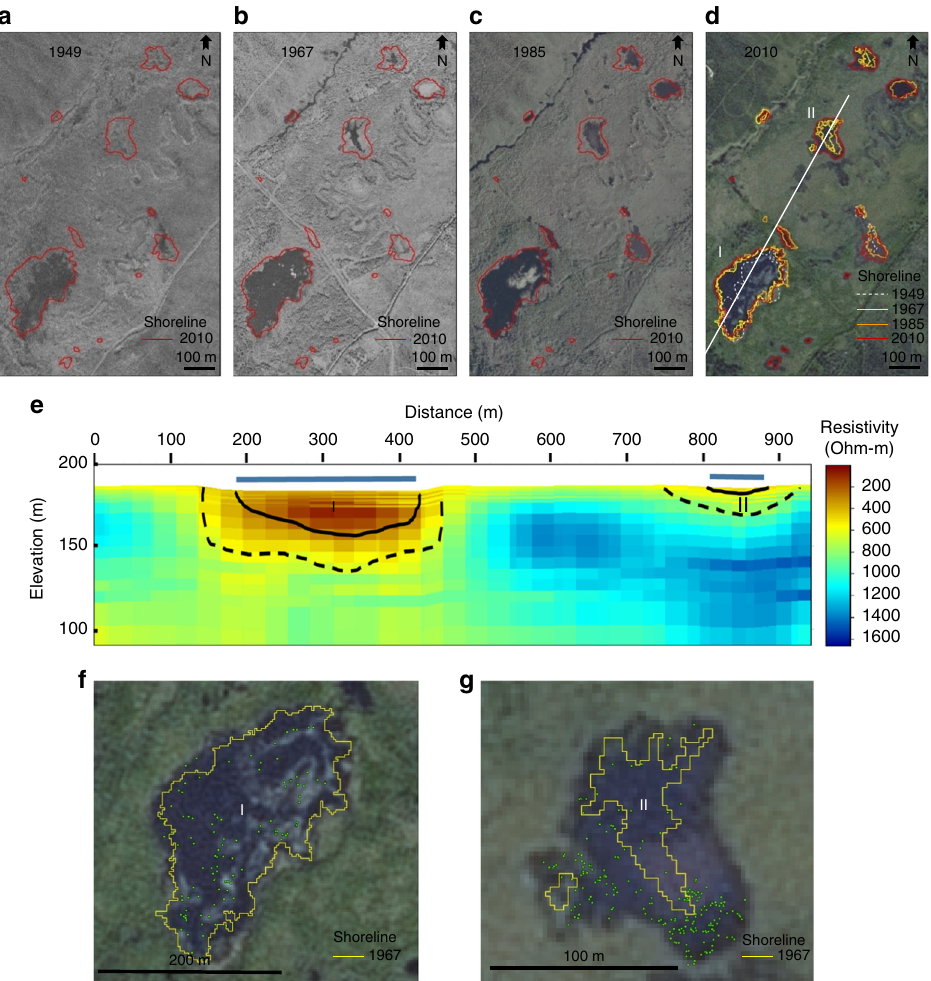
Fig. 5 Interior Alaska abrupt permafrost thaw. Time series (1949 – 2010) showing thermokarst-lake development based on historical aerial photograph ( a – c ) and 2.5-m SPOT ( d ) shoreline analysis. Dashed lines in d delineate dark areas in 1949 images interpreted as shallow, vegetated wetlands that later developed into open-water lakes. In e , thaw depth (solid line) and degraded permafrost (dashed line), interpreted from helicopter-borne electromagnetic data-derived 3D resistivity model (Supplementary Methods); extracted cross section is the white line in d . Field work shows strong, 14 C-depleted methane ebullition seeps [green dots in ( f ) Lake I, Oct. 2014 and ( g ) Lake II, Oct. 2016)] overlapping recent abrupt permafrost thaw areas (e.g., thaw since 1949 – 1967). Strong seeps are absent in lakes lacking recent abrupt thaw (Supplementary Fig. 8, Supplementary